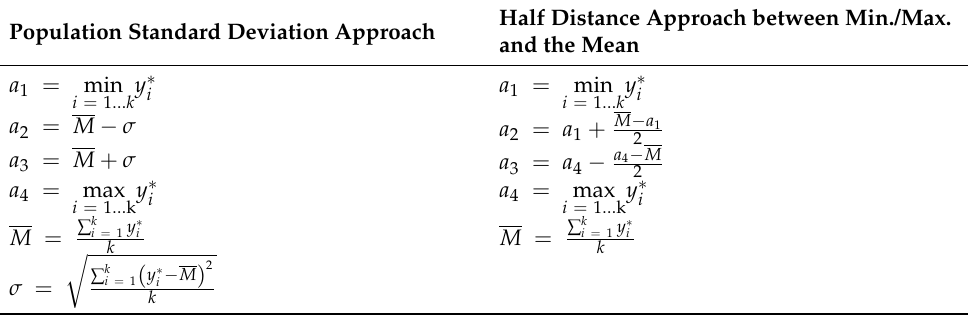
Table 4. Mathematical details of the two approaches to fuzzification. Population Standard Deviation Approach